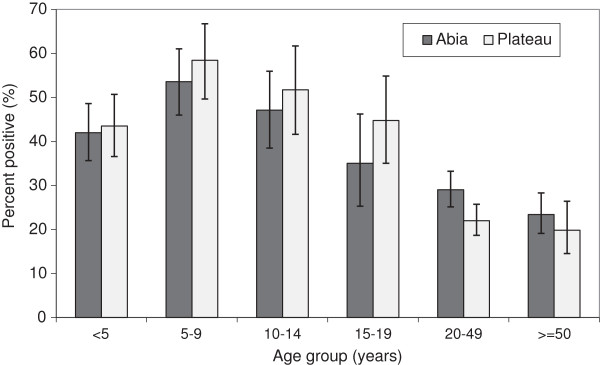
Plasmodium prevalence. Proportion of individuals testing positive for Plasmodium infection by microscopy, by age group, Abia and Plateau States, Nigeria, September 2010. In Abia, 68.1% of all infections were P. falciparum, 32.0% P. malariae with one co-infection; in Plateau, 98.7% of infections were P. falciparum, 1.4% P. malariae with two co-infections. Error bars are 95% confidence intervals.